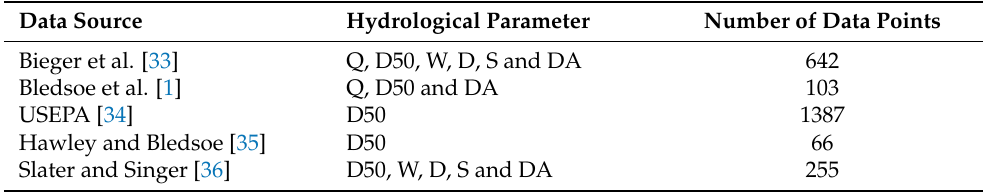
Table 1. Information on D50 data from five different sources adapted from [30]. Data